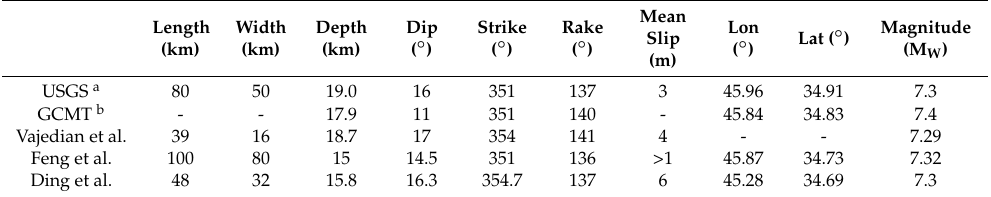
Table 1. Focal mechanism solutions for the Iran